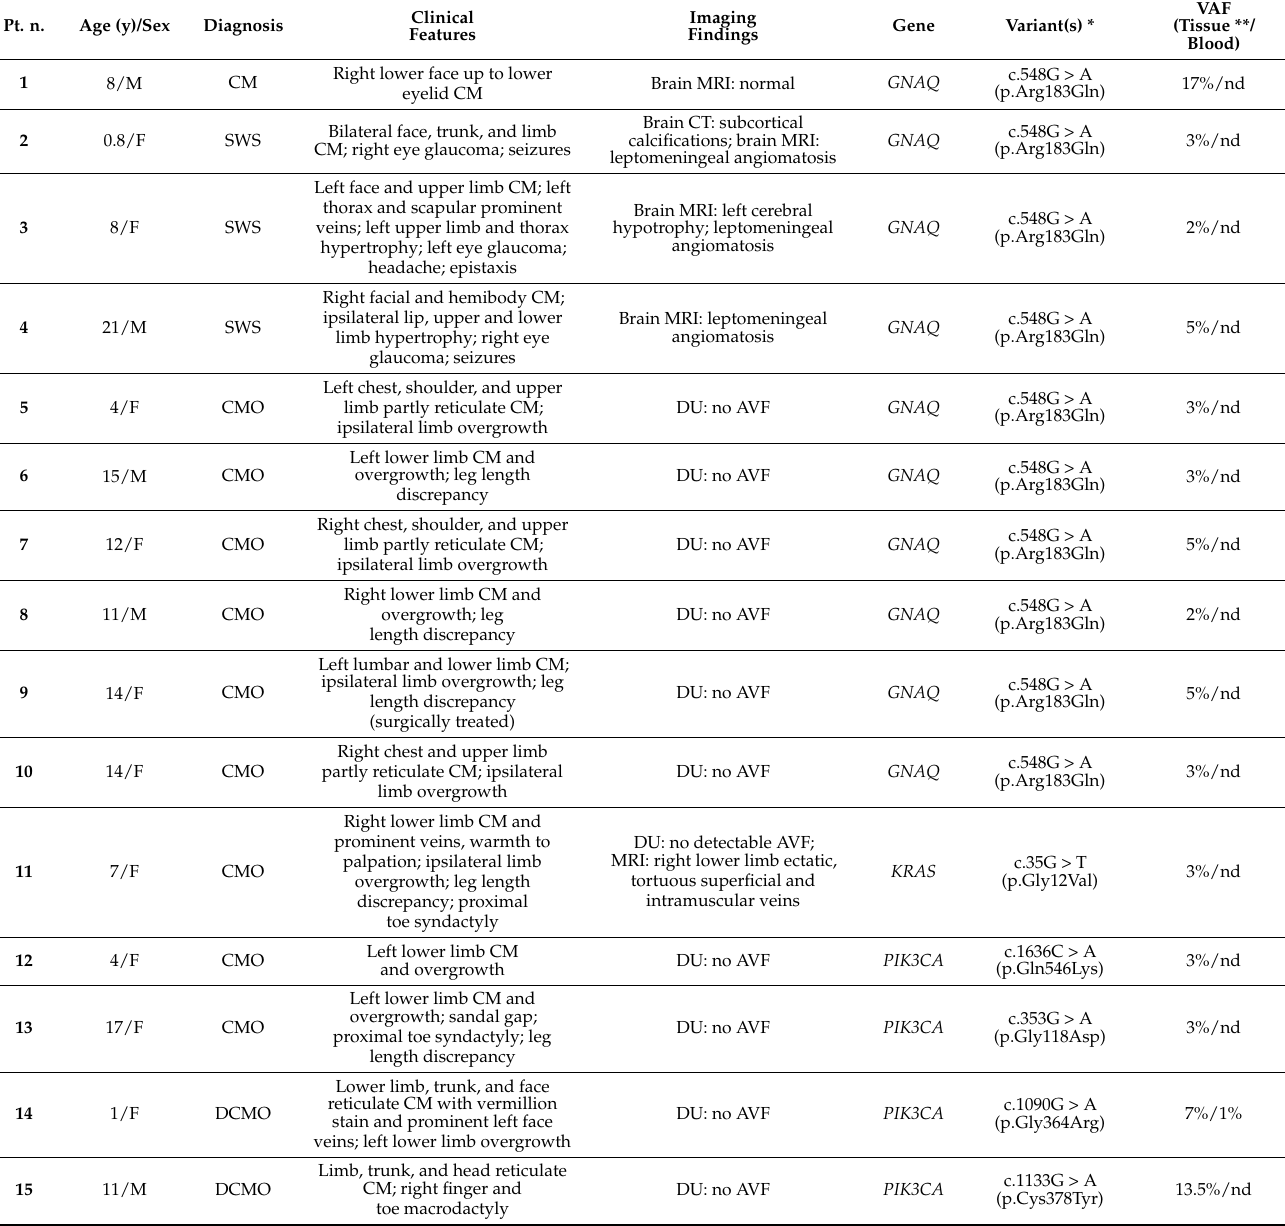
Table 1. Demographic, clinical, imaging, and molecular genetic features of patients with somatic vascular